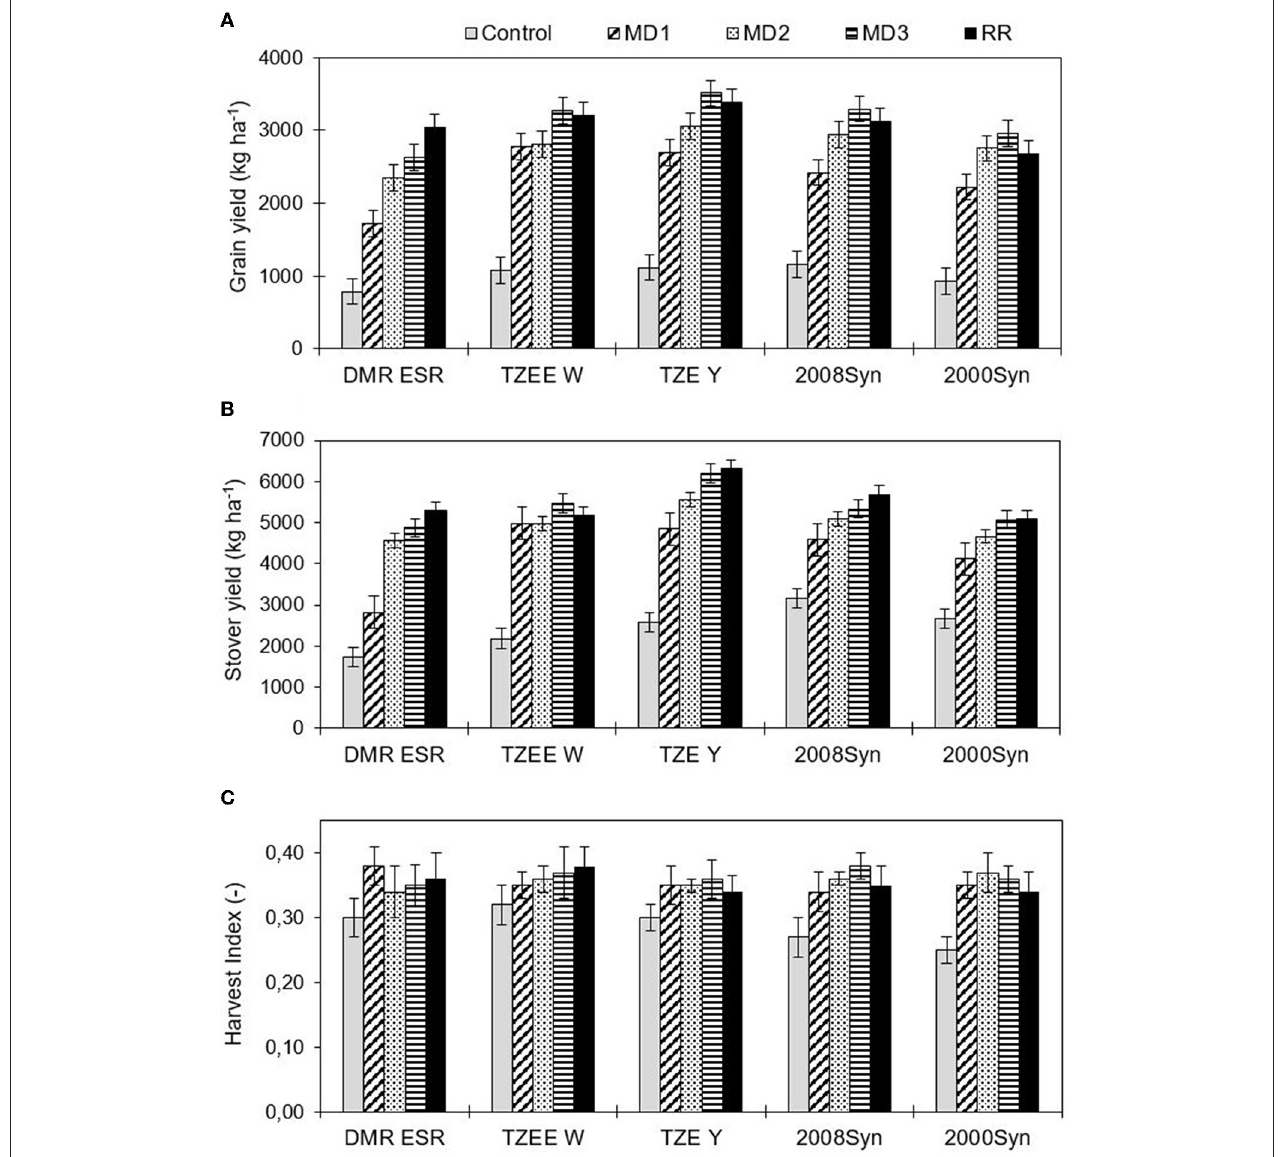
FIGURE 5 | Grain (A) , stover yield (B) , and harvest index (C) as affected by the interactions between varieties and mineral fertilizer. Control refers to the absolute unfertilized treatment; MD1 (N25P4), MD2 (N25P8), MD3 (N35P8), and RR (N76P13) refer to fertilizer microdosing options 1, 2, and 3 and the recommended fertilizer rate, respectively. Error bars represent standard